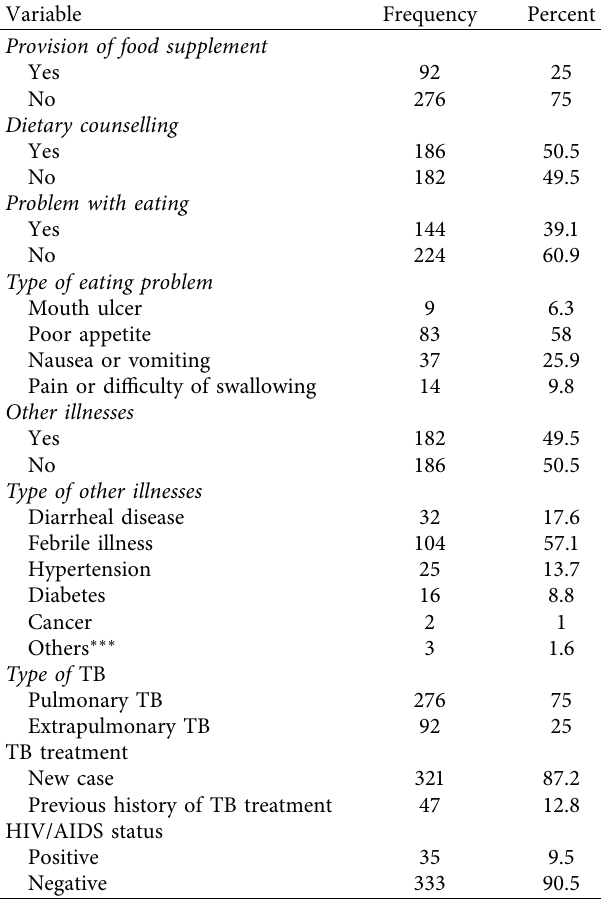
Table 2: General health status of adult TB patients in government health facilities of Shashemane, Ethiopia, 2017 ( n �